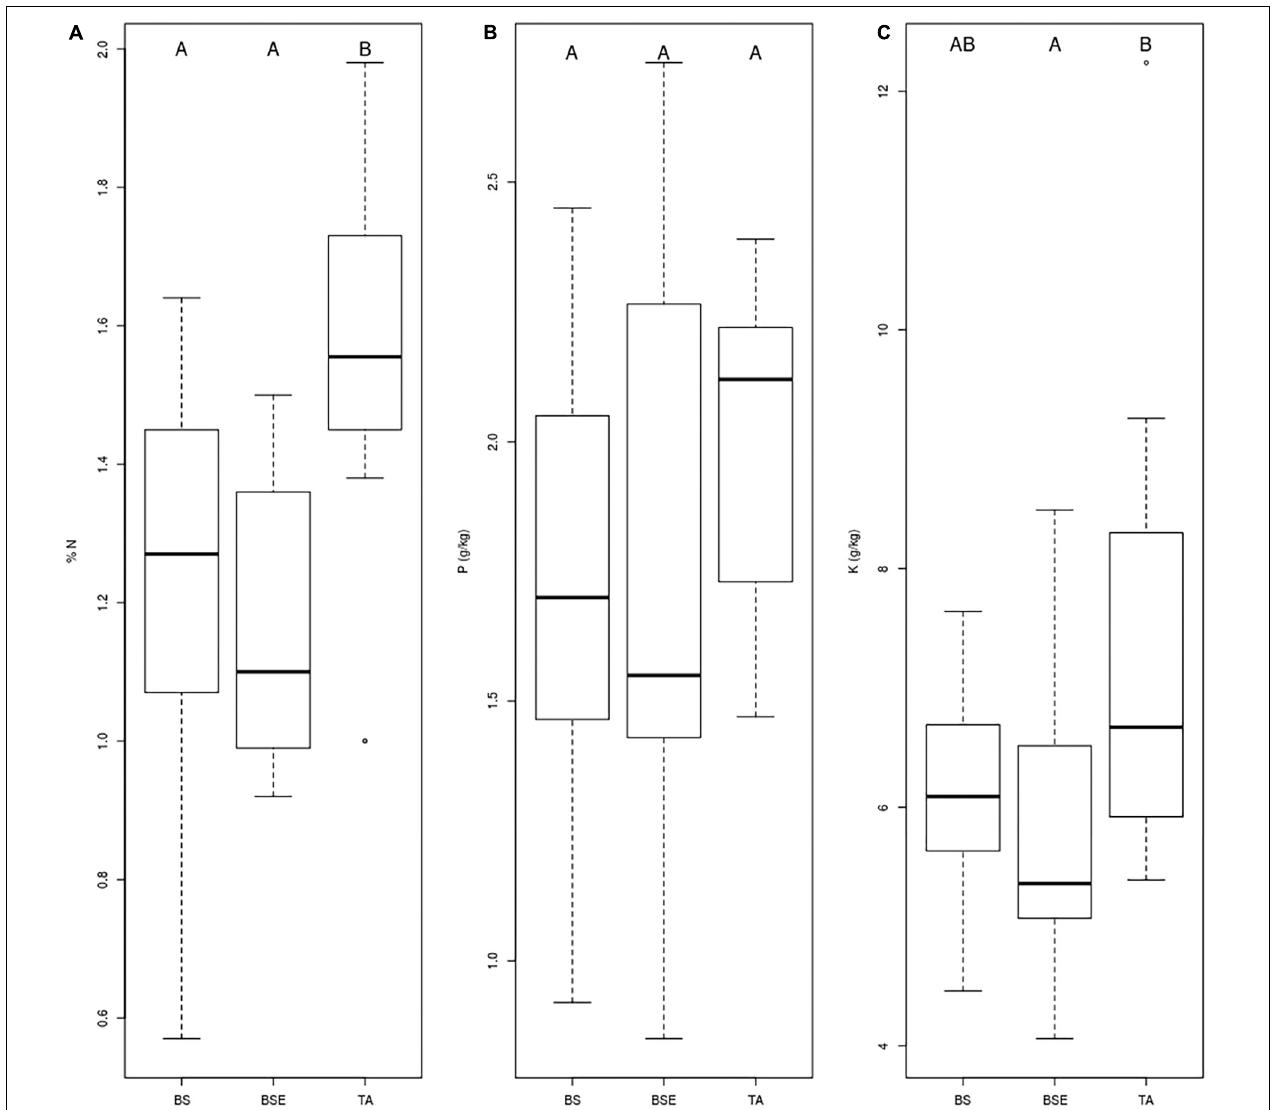
FIGURE 2 | Boxplot chart representing foliar (A) N, (B) P, and (C) K concentrations of BF needles sampled in different stands (BS, black spruce; BSE, black spruce plus ericaceous shrubs; TA, trembling aspen). Different letters indicate differences between modalities.